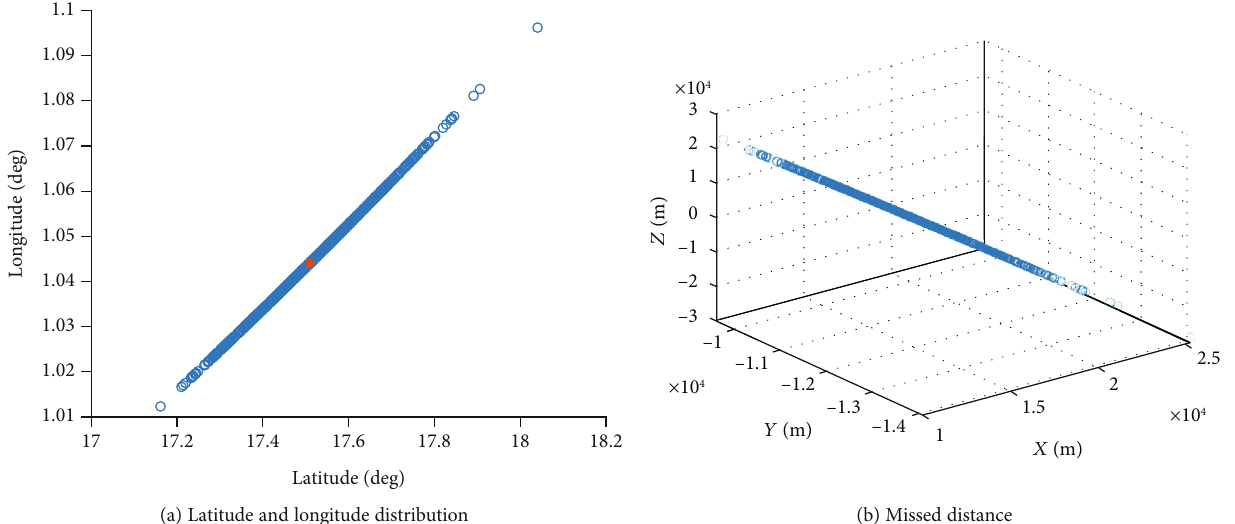
Figure 9: Monte Carlo simulation of nonlinear application in the Mars model varying density.